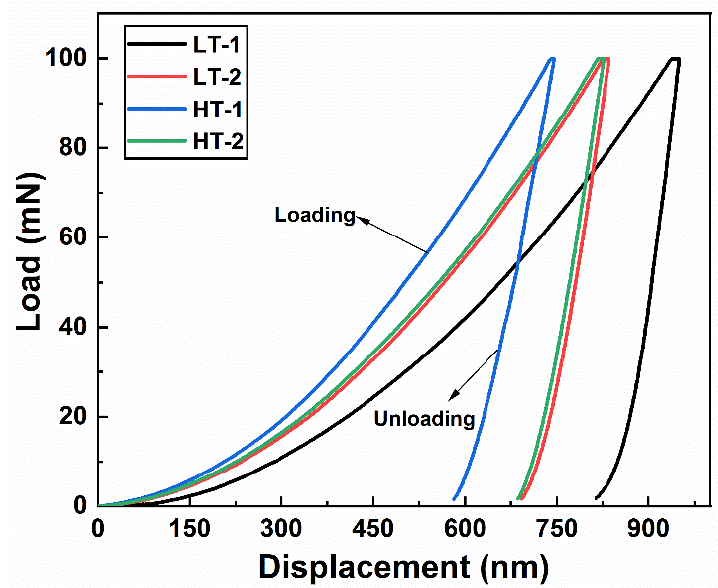
Figure 10. Load–displacement curves of ballistic steel samples. Table 6. Micro-mechanical properties of ballistic steel samples.